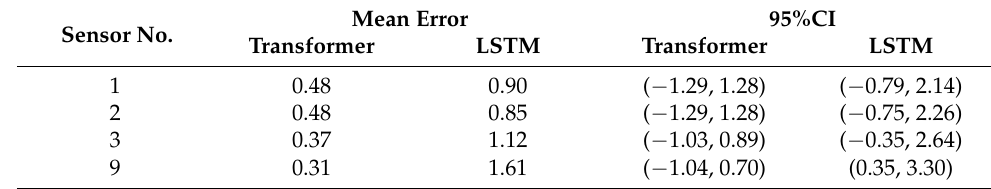
Figure 5. Prediction error statistics and error distribution for Transformer and LSTM: ( a ) Error curve of sensor S01. ( b ) Fitting curve of normal distribution of sensor S01. ( c ) Error curve of sensor S02. ( d ) Fitting curve of normal distribution of sensor S02. ( e ) Error curve of sensor S03. ( f ) Fitting curve of normal distribution of sensor S03. ( g ) Error curve of sensor S09. ( h ) Fitting curve of normal distribution of sensor S13. Table 1. Mean error and 95%CI statistical results.